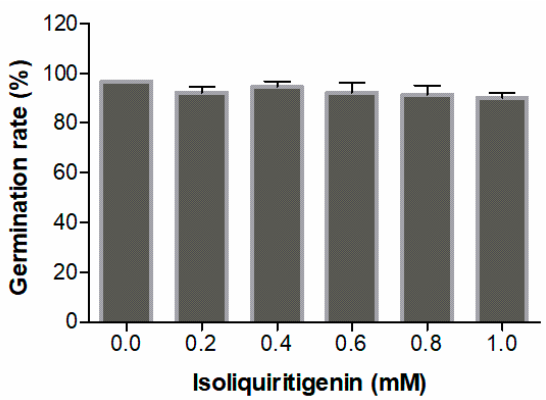
Figure 2. Allelopathic effect of isoliquiritigenin on the germination of lettuce seeds. Values are expressed as a percentage of the mean compared to 30 plants. Error bars are one standard deviation of the mean. N = 3.